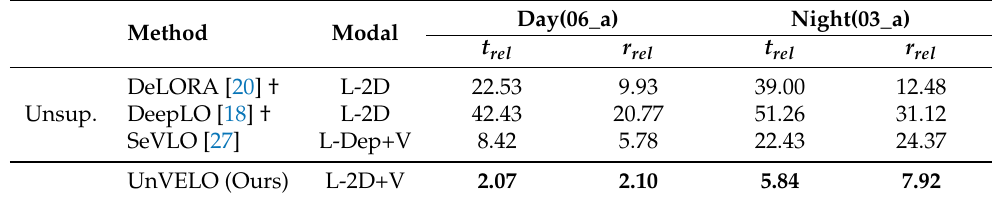
Table 5. Evaluation results on the DSEC dataset. The Modal column denotes the modalities of network inputs, where “L” stands for LiDAR and “V” stands for visual. The best results are bold. Method Modal